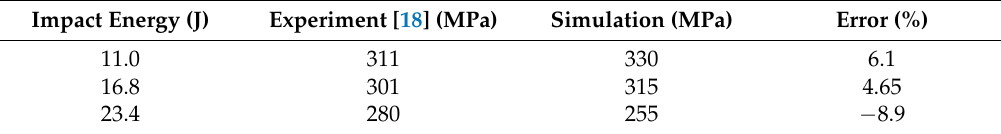
Table 5. Comparison between the experiment and simulation for residual strength.